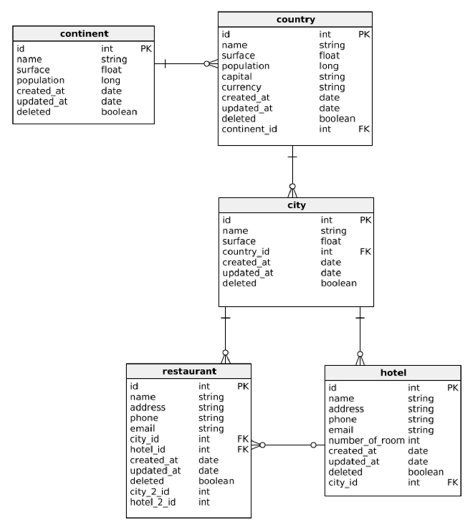
Figure 1. Relational database structure.